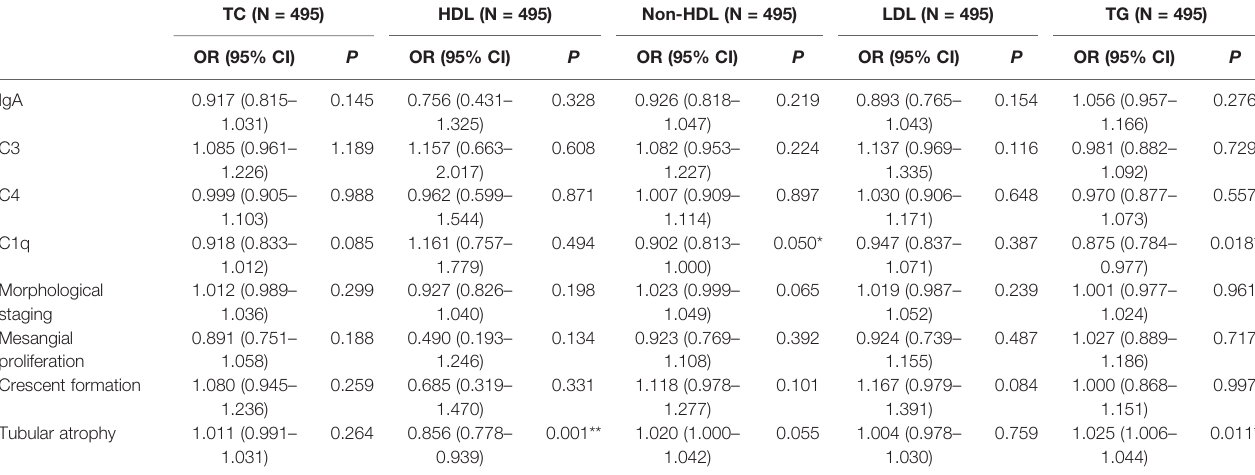
TABLE 2 | Logistic regression analyses for lipid pro fi les and pathological indicators except for IgG4 dominant and PLA2R deposit. TC (N =